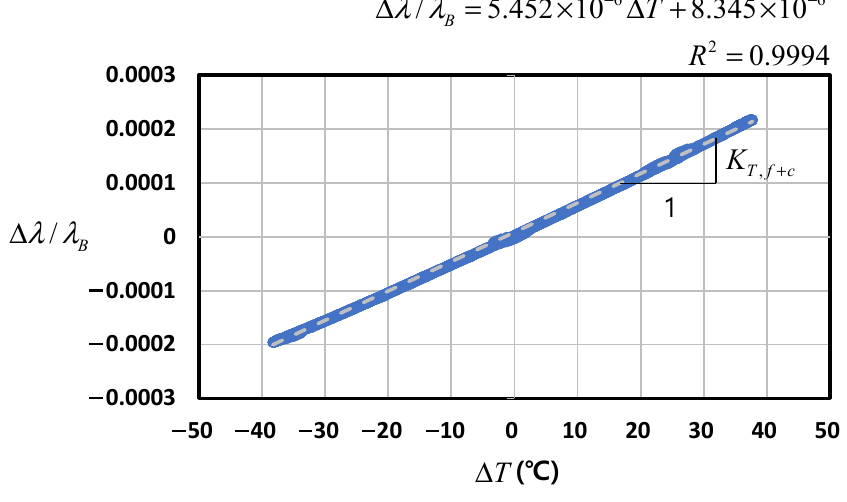
Figure 7. Wavelength–temperature relation of FBG + CFRP core wire.